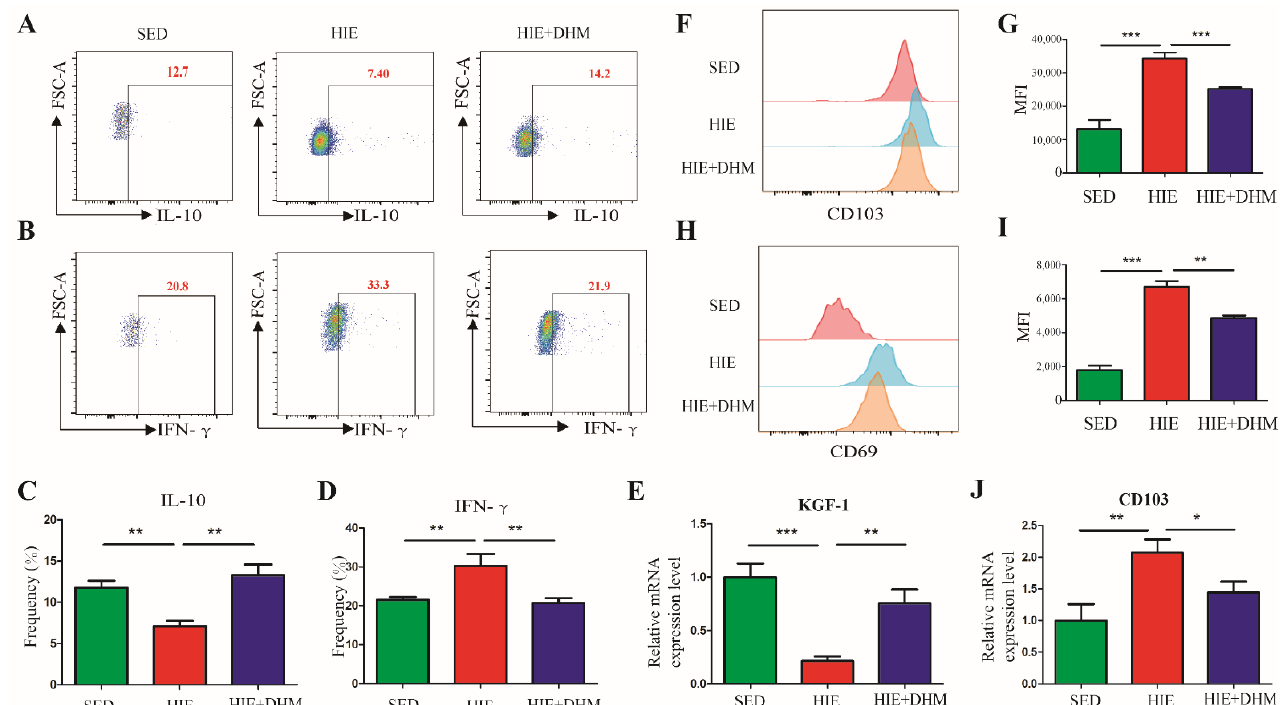
Figure 4. DHM modulates the immune function of CD8 αα + IELs in mice following high-intensity exercise. ( A , B ) After the IELs were stimulated by PMA and ionomycin with Golgi Stop for 6 h, IL-10 ( A ) and IFN- γ ( B ) expressions in CD8 αα + IELs cells were analyzed by flow cytometry (cells were gated by CD3 + and CD8 α + CD8 β − ) ( n = 4). ( C , D ) Frequencies of IL-10-expressing cells and IFN- γ -expressing cells in CD8 αα + IELs population in the small intestines were shown ( n = 4). ( E ) The mRNA expression level of KGF-1 in small intestine tissues were assessed by qRT-PCR assay ( n = 6). ( F , G ) The expression of the surface marker CD103 on CD8 αα + IELs of the small intestine in mice was detected by flow cytometry and the mean fluorescence intensity (MFI) among three group mice was shown (cells were gated by CD3 + and CD8 α + CD8 β − ) ( n = 4). ( H , I ) The expression of the surface marker CD69 on CD8 αα + IELs in the small intestine of mice was detected by flow cytometry and the mean fluorescence intensity (MFI) among the three groups of mice was shown (cells were gated by CD3 + and CD8 α + CD8 β − ) ( n = 4–5). ( J ) The mRNA expression level of CD103, an activation and migration marker of CD8 αα + IELs in small intestine tissues was assessed by qRT-PCR assay ( n = 5–6). Data were expressed as means ± SEM. The experiments were replicated 2–3 times. The data shown were from one representative experiment, * p < 0.05, ** p < 0.01 and *** p < 0.001. Multiple groups were tested by one-way ANOVA followed by Bonferroni’s post hoc test.